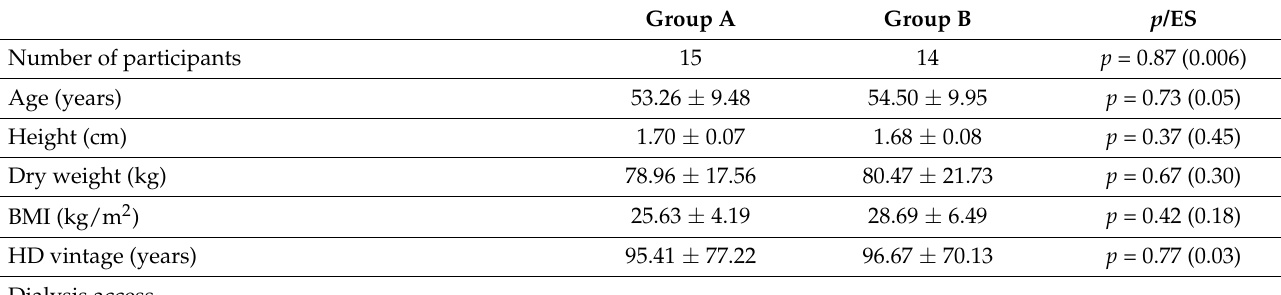
Table 1. Clinical characteristics of the KT